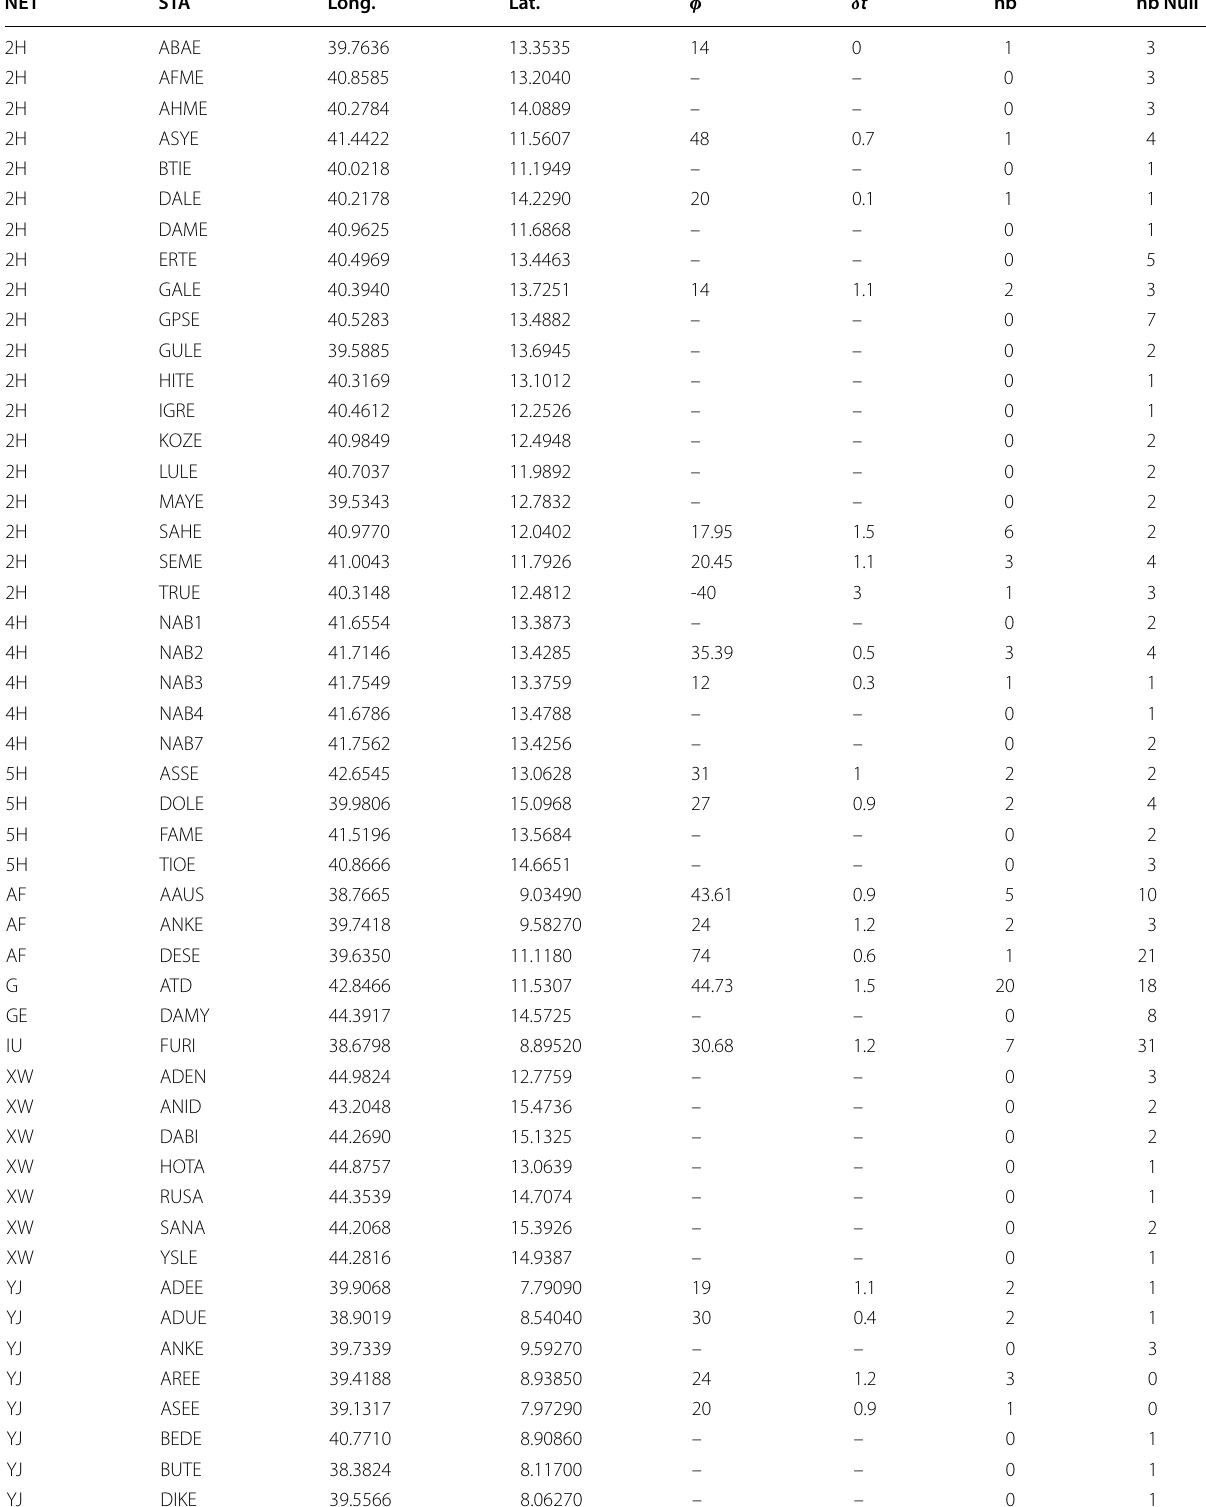
Table 1 Summary of all shear-wave splitting parameters measured in this study for the Afar triple junction region NET STA Long.